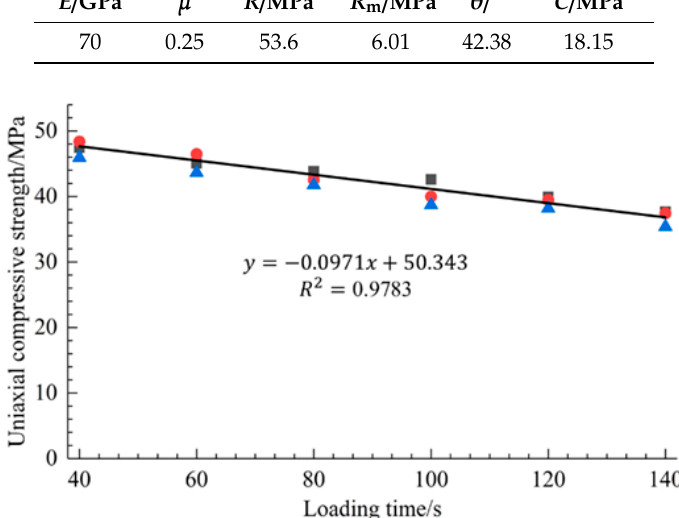
Figure 8. Excitation time versus compression strength curve.